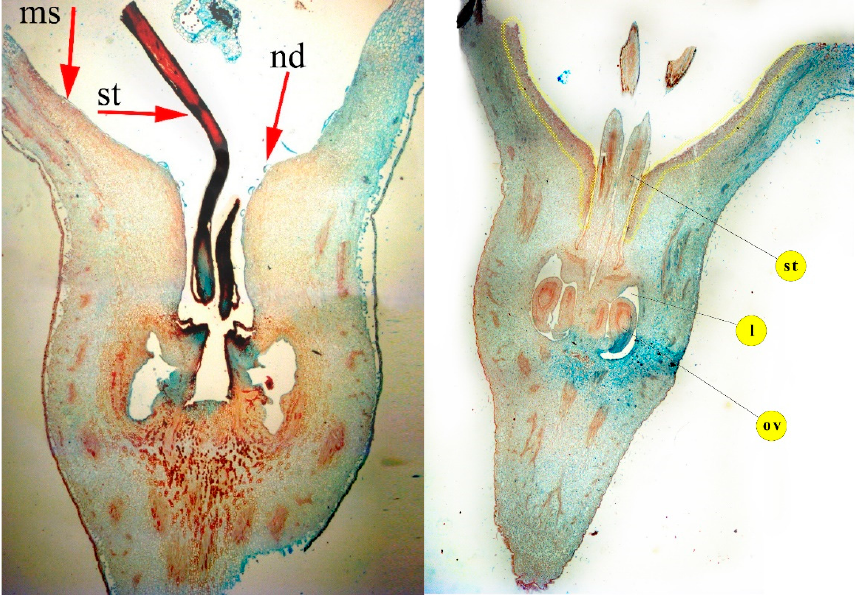
Figure 2. Longitudinal section of a pear flower receptacle showing the position of nectary, modified stomata and secreted nectar droplets in Bella di Giugno ( left ) and Alexander Lucas ( right ) cultivars (×10; LM). Nectary tissue is framed in yellow ( right ). Abbreviations: nd—nectar droplet; ms—modified stomata; st—style; ov—ovules (2 per locule); l—locule.